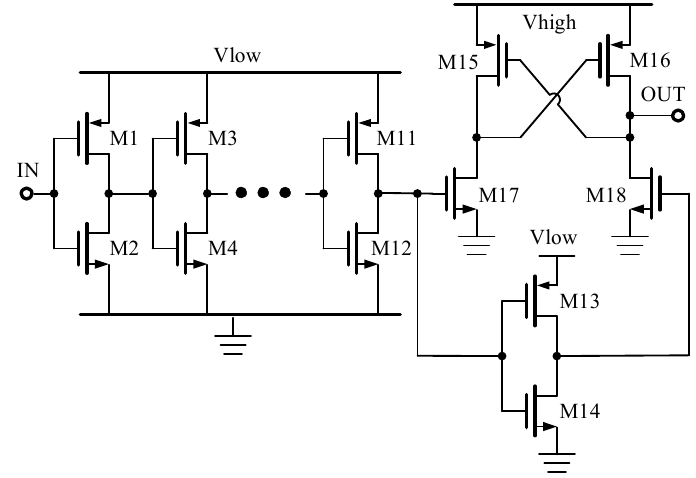
Figure 10. Schematic of a latch-based full-swing level-shifter.